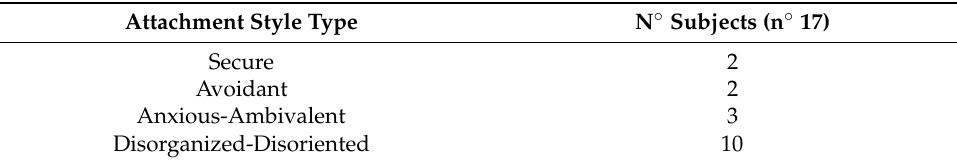
Table 2. Attachment style frequency in the target group.